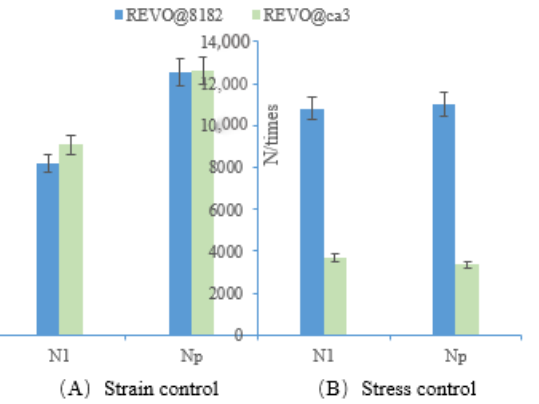
Figure 5. Evaluation results of N 1 and N p. under stress (100 kpa)/strain (4.5%) mode.